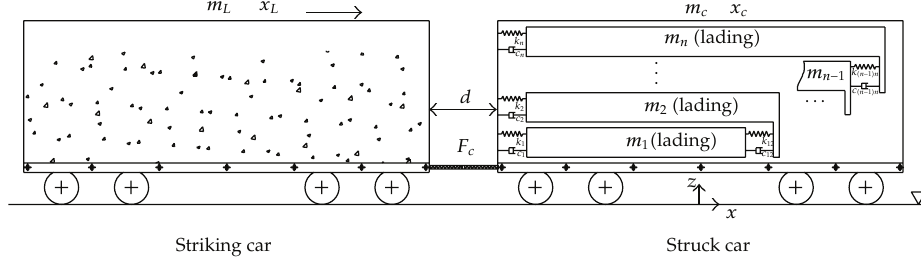
Figure 2: Car-to-car end impact dynamic